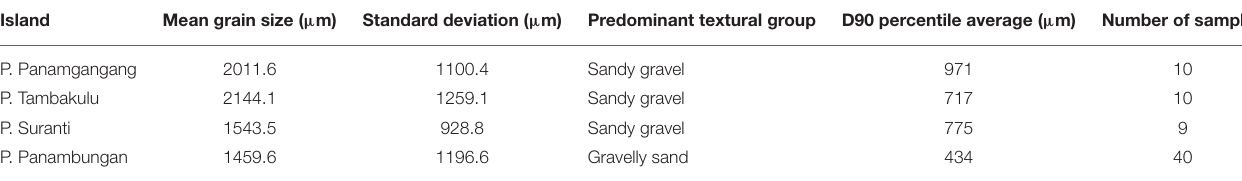
TABLE 1 | Mean grain size distribution of surface sediments on P. Suranti, P. Tambakulu, P. Panamgangang, and P. Panambungan.